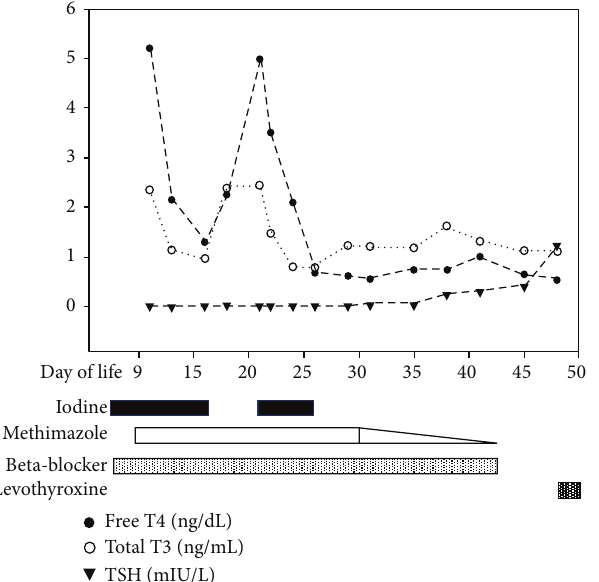
Figure 1: Free thyroxine (FT4) and thyroid stimulating hormone (TSH) levels and treatment course during hospitalization at our institution. Iodine, methimazole, beta-blocker, and levothyroxine are shown as bars at the end of the graph. The triangle at the end of methimazole bar represents the time that methimazole was started to be tapered.